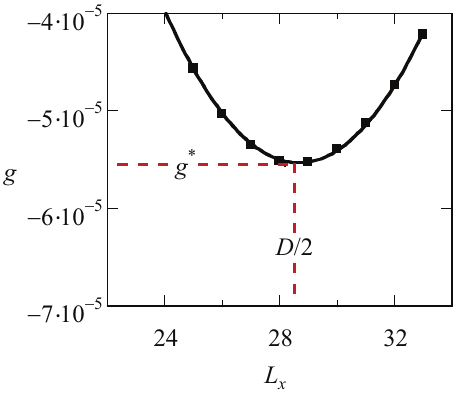
Figure 1. Free energy density g (in units of k B T / b 3 ) as a function of the spacing L x for a LAM phase f = 0.5, N = 1600 and χ = 0.09. The line is a parabolic fit through the data points. The optimal spacing D (in units b ) as well as the corresponding optimal free energy density are